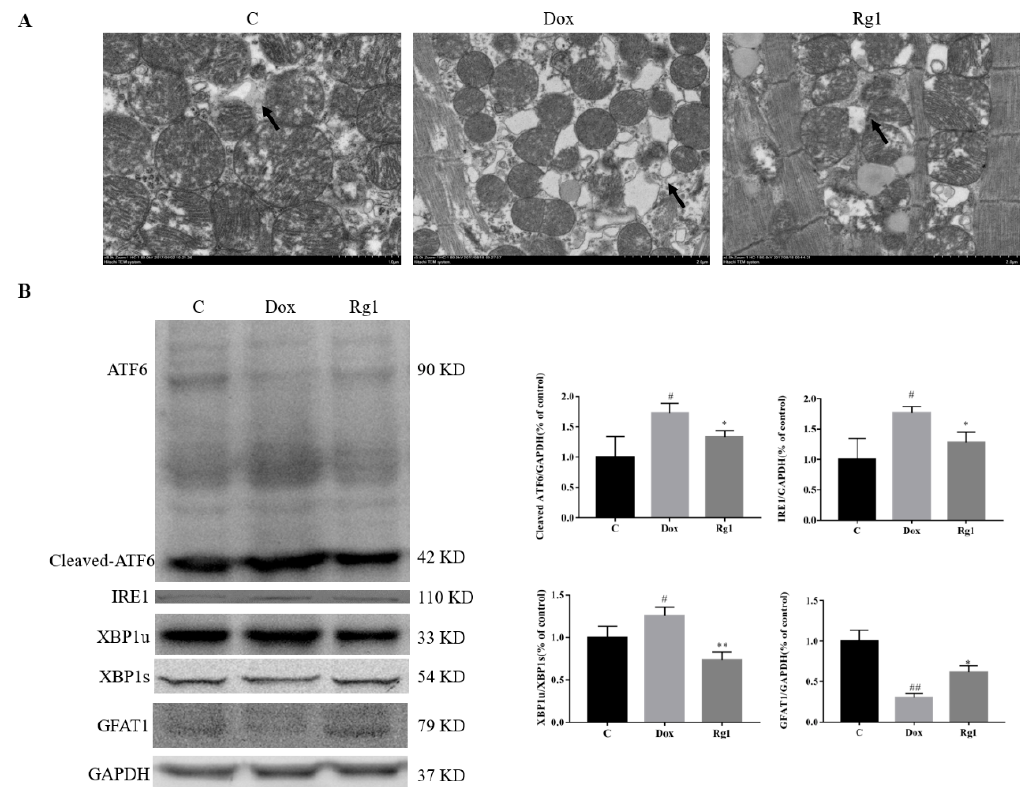
Figure 4. The anti-endoplasmic reticulum stress effects of Rg1 in mice heart. ( A ) Electron microscope images of ER (indicated by arrow, 50,000 × ) from three groups. ( B ) Expression of ATF6, Cleaved ATF6, IRE1, XBP1s, XBP1u and GFAT1 protein in mouse heart. GAPDH was used as the loading control. # p < 0.05, ## p < 0.01 vs. C group, * p < 0.05, ** p < 0.01 vs DOX group.